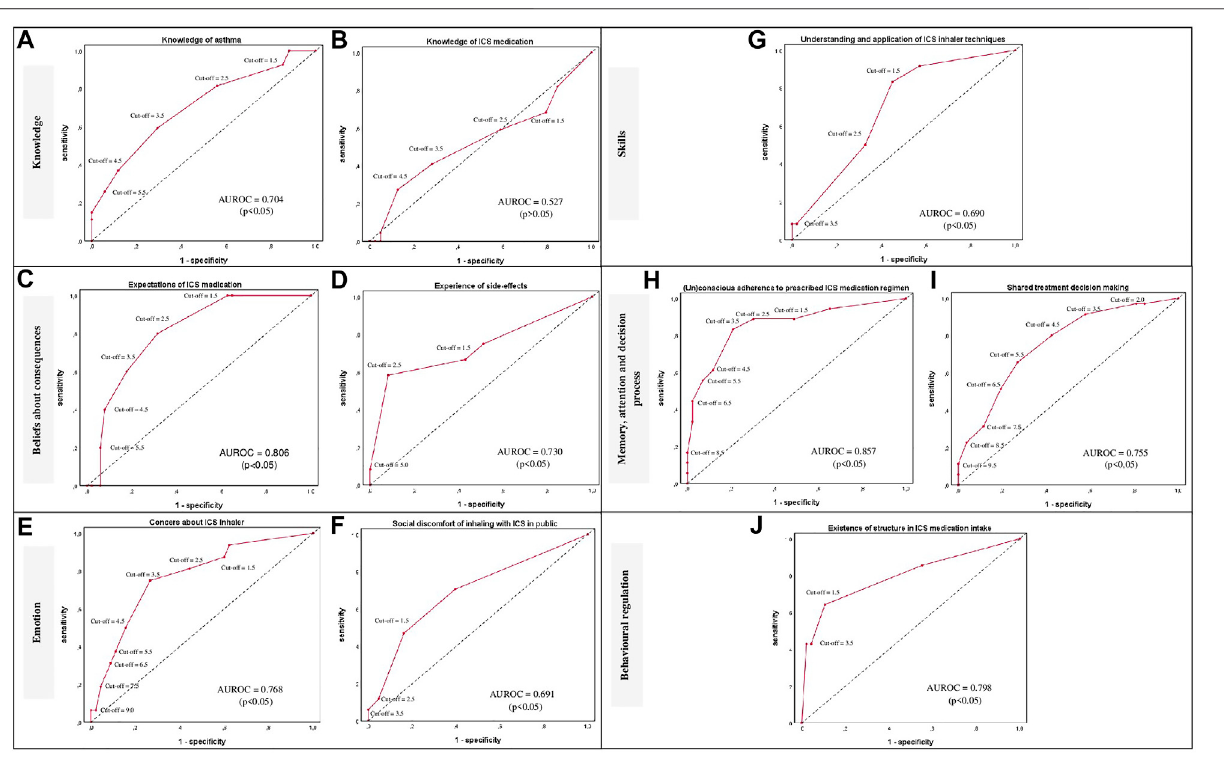
Frontiers in Pharmacology |